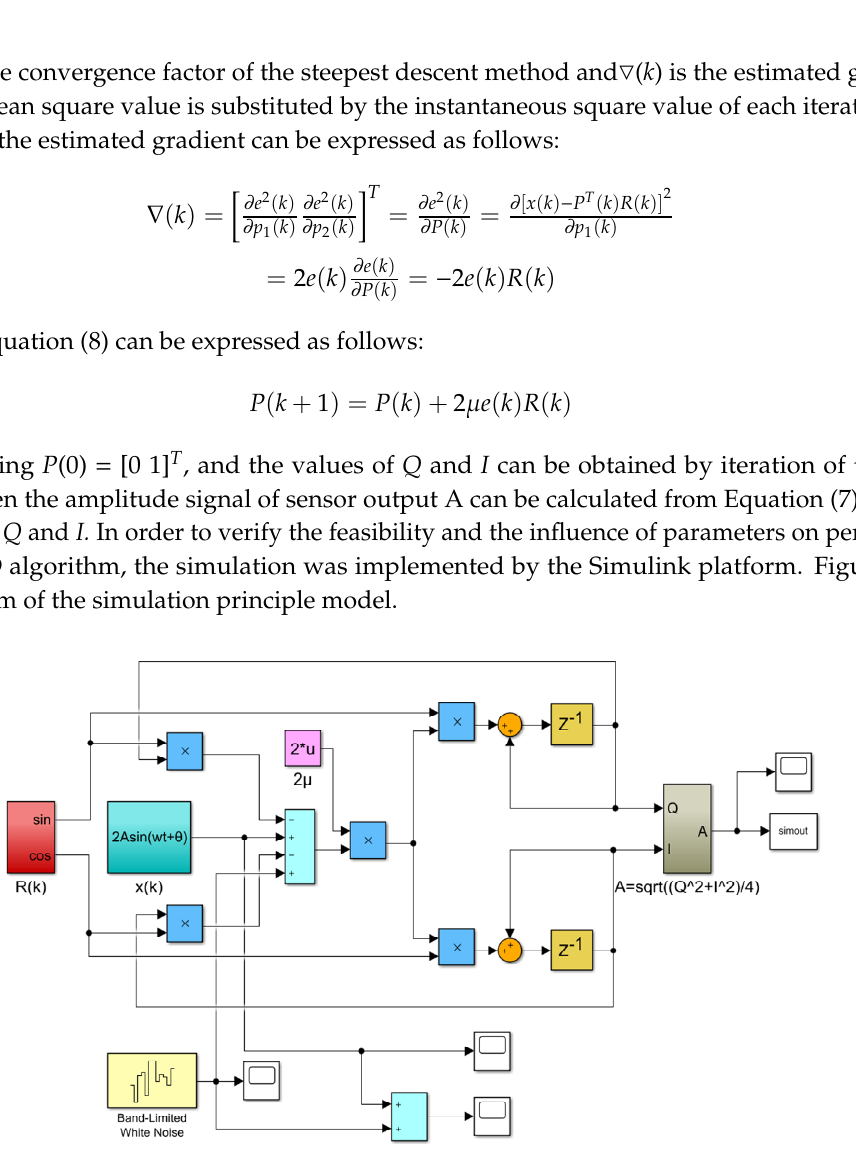
Figure 12. Simulink model of LMSD demodulation algorithm.